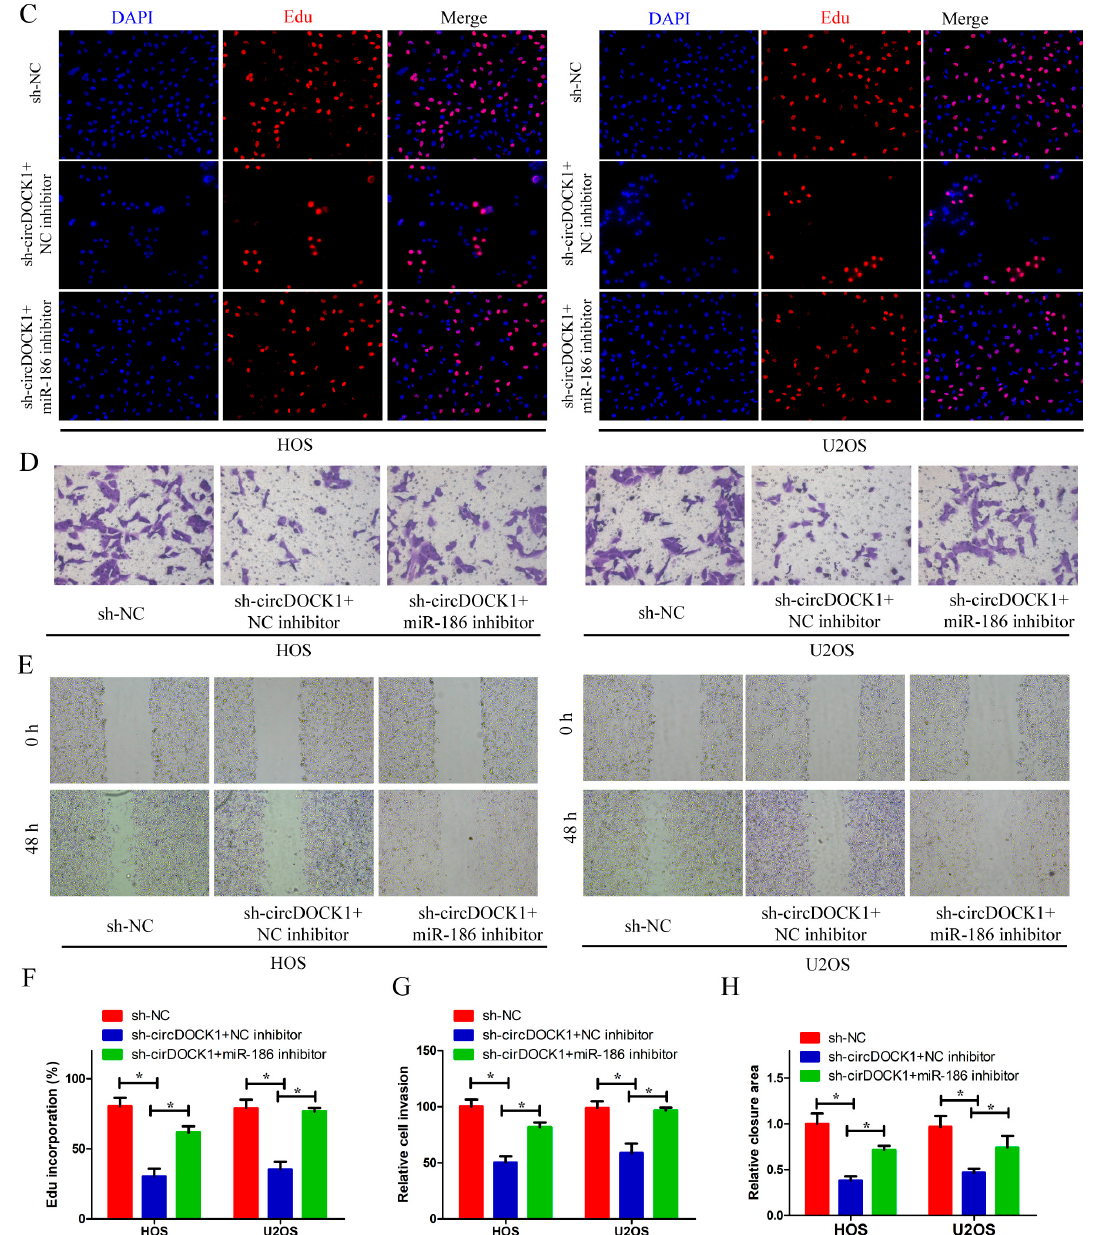
Figure 4. MiR-186 knockdown partly reverses the effect of sh-circDOCK1 on OS progression. ( A ) The miR-186 level was evaluated in OS cells following transfection with inhibitors of miR-186 and sh- circDOCK1. ( B , C , F ) CCK-8 and EdU assay outcomes concerning cellular proliferative potential. ( D , E , G , H ) Wound-healing and Transwell assay findings for cellular motility and invasion. * p < 0.05, ** p <